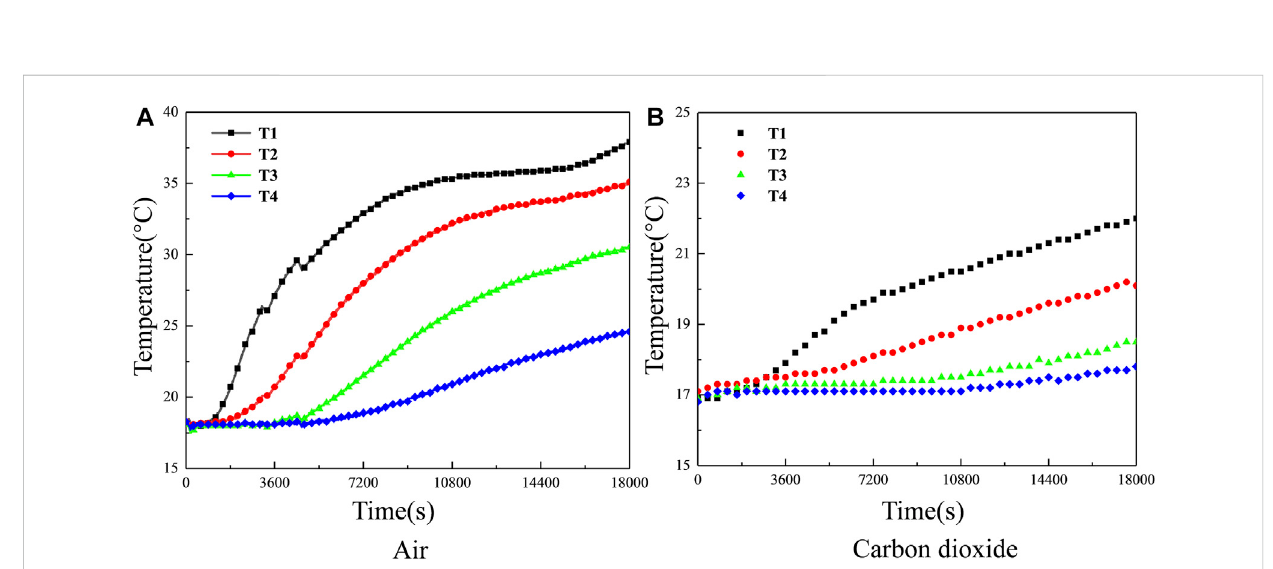
production of rock bed, the seepage movement of heat-carrying gas, rock deformation, and heat transfer involves the mutual coupling of the hydraulic fi eld, mechanical fi eld, and thermal fi eld.